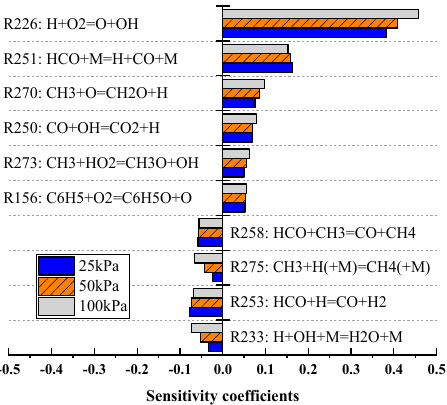
Figure 11. Variations in the sensitivity coefficients of key reactions with pressure.